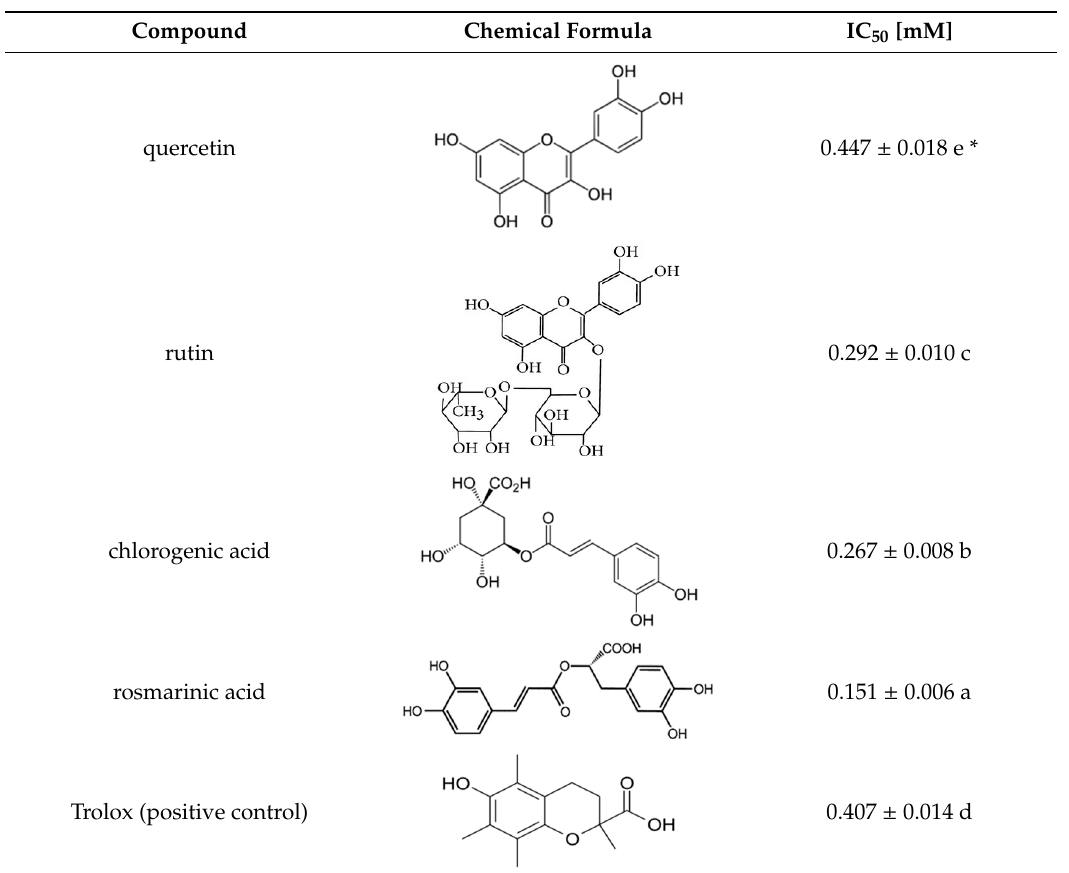
Table 1. Chemical structure and ABTS (2,2 ′ -azinobis-(3-ethylbenzothiazoline-6-sulfonic acid) radical scavenging properties of chosen polyphenols (quercetin, rutin, chlorogenic acid, rosmarinic acid) expressed in IC 50 (Efficient Concentration), n = 9.